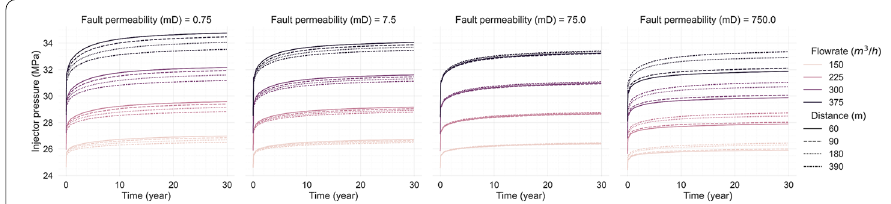
Fig. 5 Injection pressure over time for fault permeability of 0.75 mD, 7.5 mD, 75 mD and 750 mD, FWD of 60 m, 90 m, 180 m and 360 m and injection temperature of 303.15